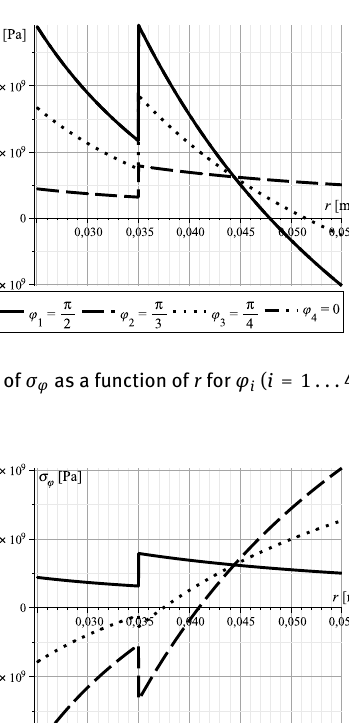
Figure 28: Plot of M ( φ ) (Example 5.3).